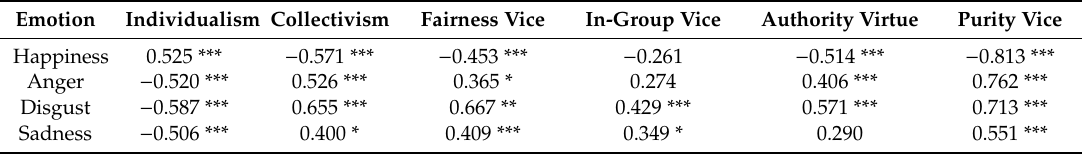
Table 6. Correlation coe ffi cients between emotions and moral concern / cultural values.